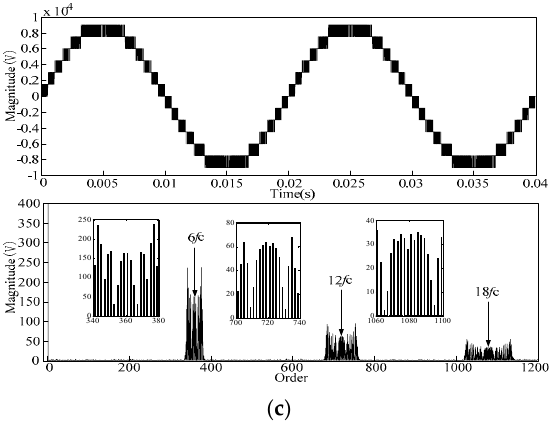
Figure 7. Simulation Results. ( a ) 1 module. ( b ) 2 modules cascaded inverter. ( c ) 3 modules cascaded inverter.